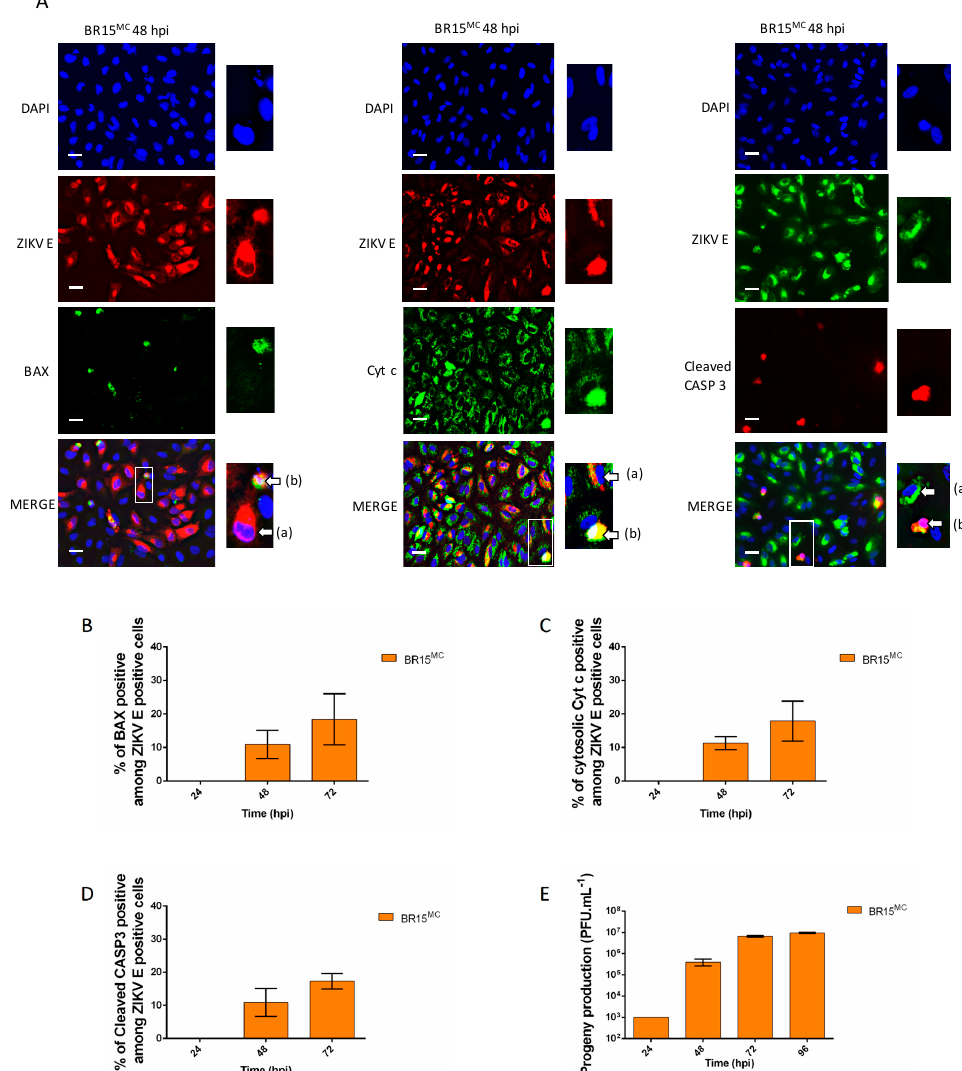
Figure 2. BR15 MC does not cause significant activation of apoptosis until late in infection. A549 cells were infected with BR15 MC at MOI of 1. ( A ) Cells were immunostained for active mitochondrial BAX, cytochrome c (Cyt c), ZIKV E and cleaved caspase 3 (CASP 3), 48 hpi. The white scale bar represents 10 µ m. Right panel series show magnified details of selected cells from the × 200 microscopic field (white square). Arrows indicate (a): an infected cell (stained for ZIKV E) and (b): an infected and apoptotic cell (stained for ZIKV E and with mitochondrial localization of BAX or Cytosolic Cyt c or cleaved CASP3. ( B ) Percentage of A549 infected cells co-immunolabeled for ZIKV E and for active mitochondrial BAX, among the ZIKV E positive cells were determined at 24, 48 and 72 hpi. ( C ) Percentage of A549 infected cells co-immunolabeled for ZIKV E and for cytosolic Cyt c, among the ZIKV E positive cells were determined at 24, 48 and 72 hpi. ( D ) Percentage of A549 infected cells immunostained with anti-cleaved CASP 3 antibody among the ZIKV E positive cells were followed at 24, 48 and 72 hpi. ( E ) The infectious viral particles were collected from infected cell culture supernatants at 24, 48, 72 and 96 hpi and titrated. Values represent the mean and standard deviation of three independent experiments.